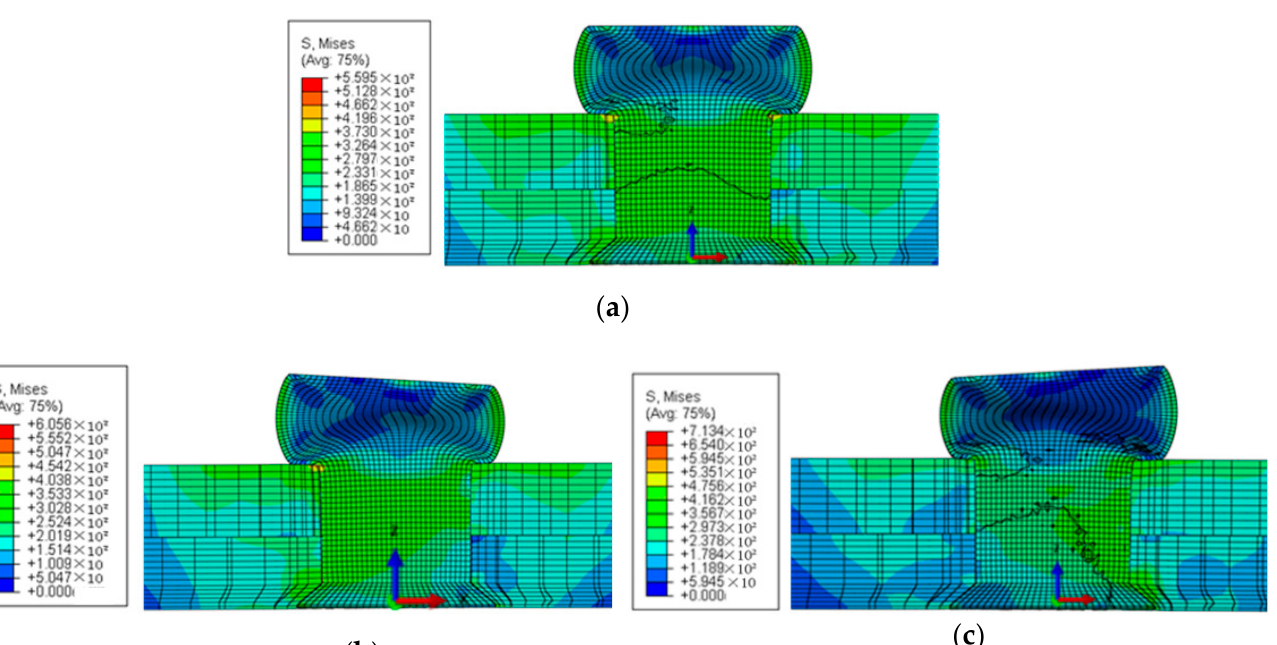
Figure 12. Simulation results of riveted parts after pressing riveting at different angles in the same direction (0 ◦ ) (unit: MPa): ( a ) the reference deformation and stress result of the punch at 0 ◦ when the punch is not deflected; ( b ) the deformation and stress result of the punch pressing down at an angle of 3 ◦ in the direction of 0 ◦ ; ( c ) the deformation and stress result of the punch pressing down at an angle of 3 ◦ in the direction of 180 ◦ .